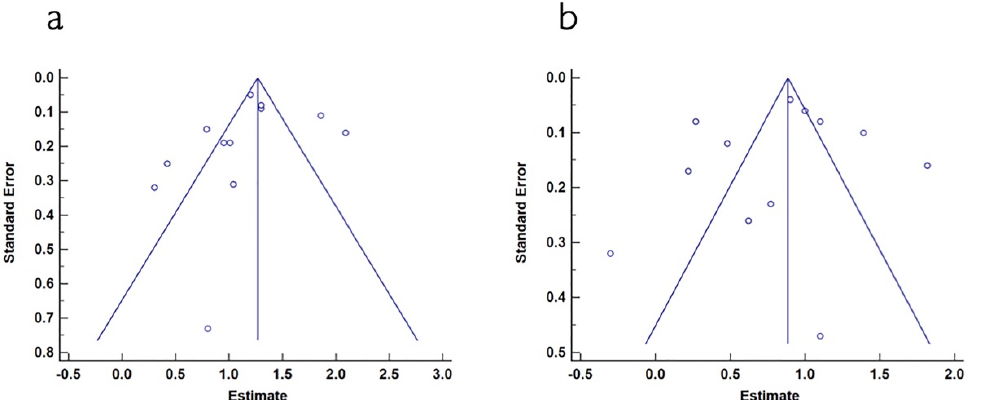
Figure 10. Forest plot for gingival thickness in test group (collagen matrix). The weighted mean is presented at CI 95%. Heterogeneity was determined using Higgins (I 2 ). A random-effects model was applied. Statistical significance was set at 0.05.